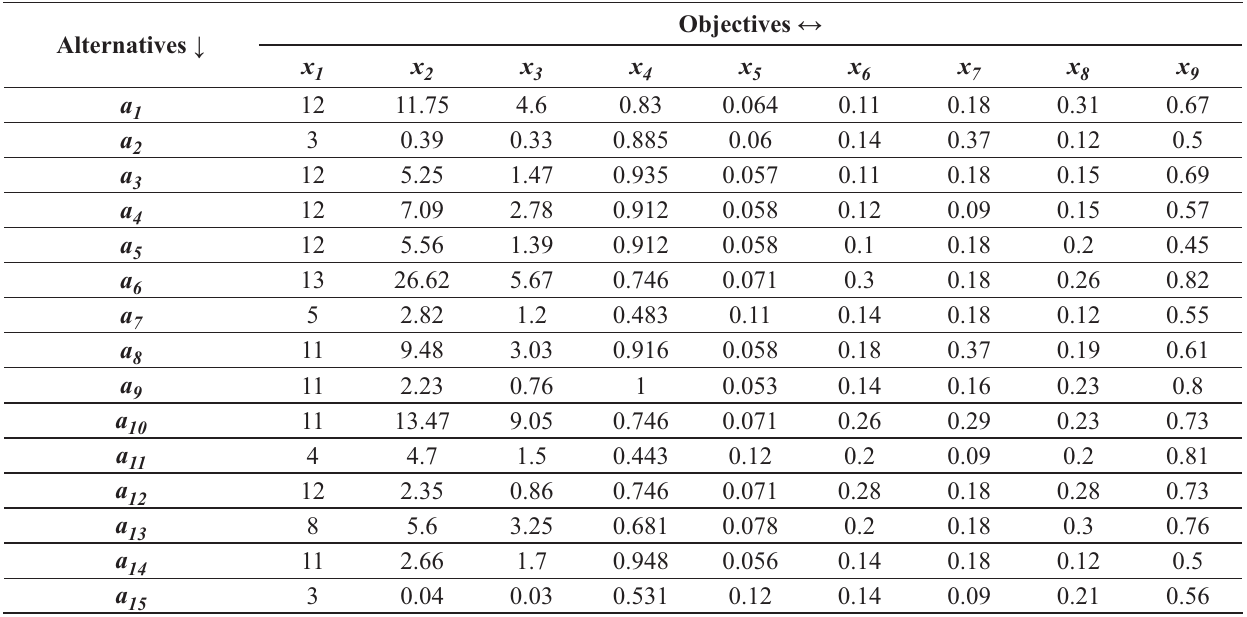
Table2. Initial decision making matrix of 15 contractors of dwellings in